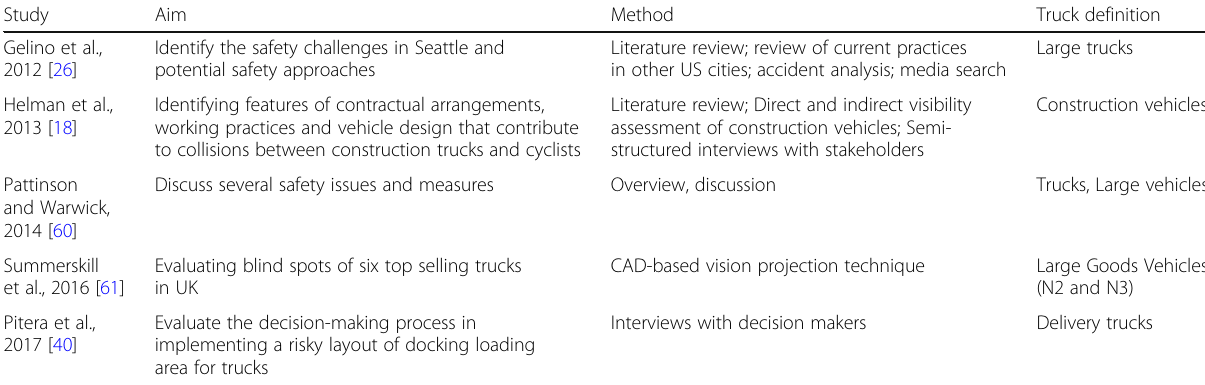
Table 4 Characteristics of other